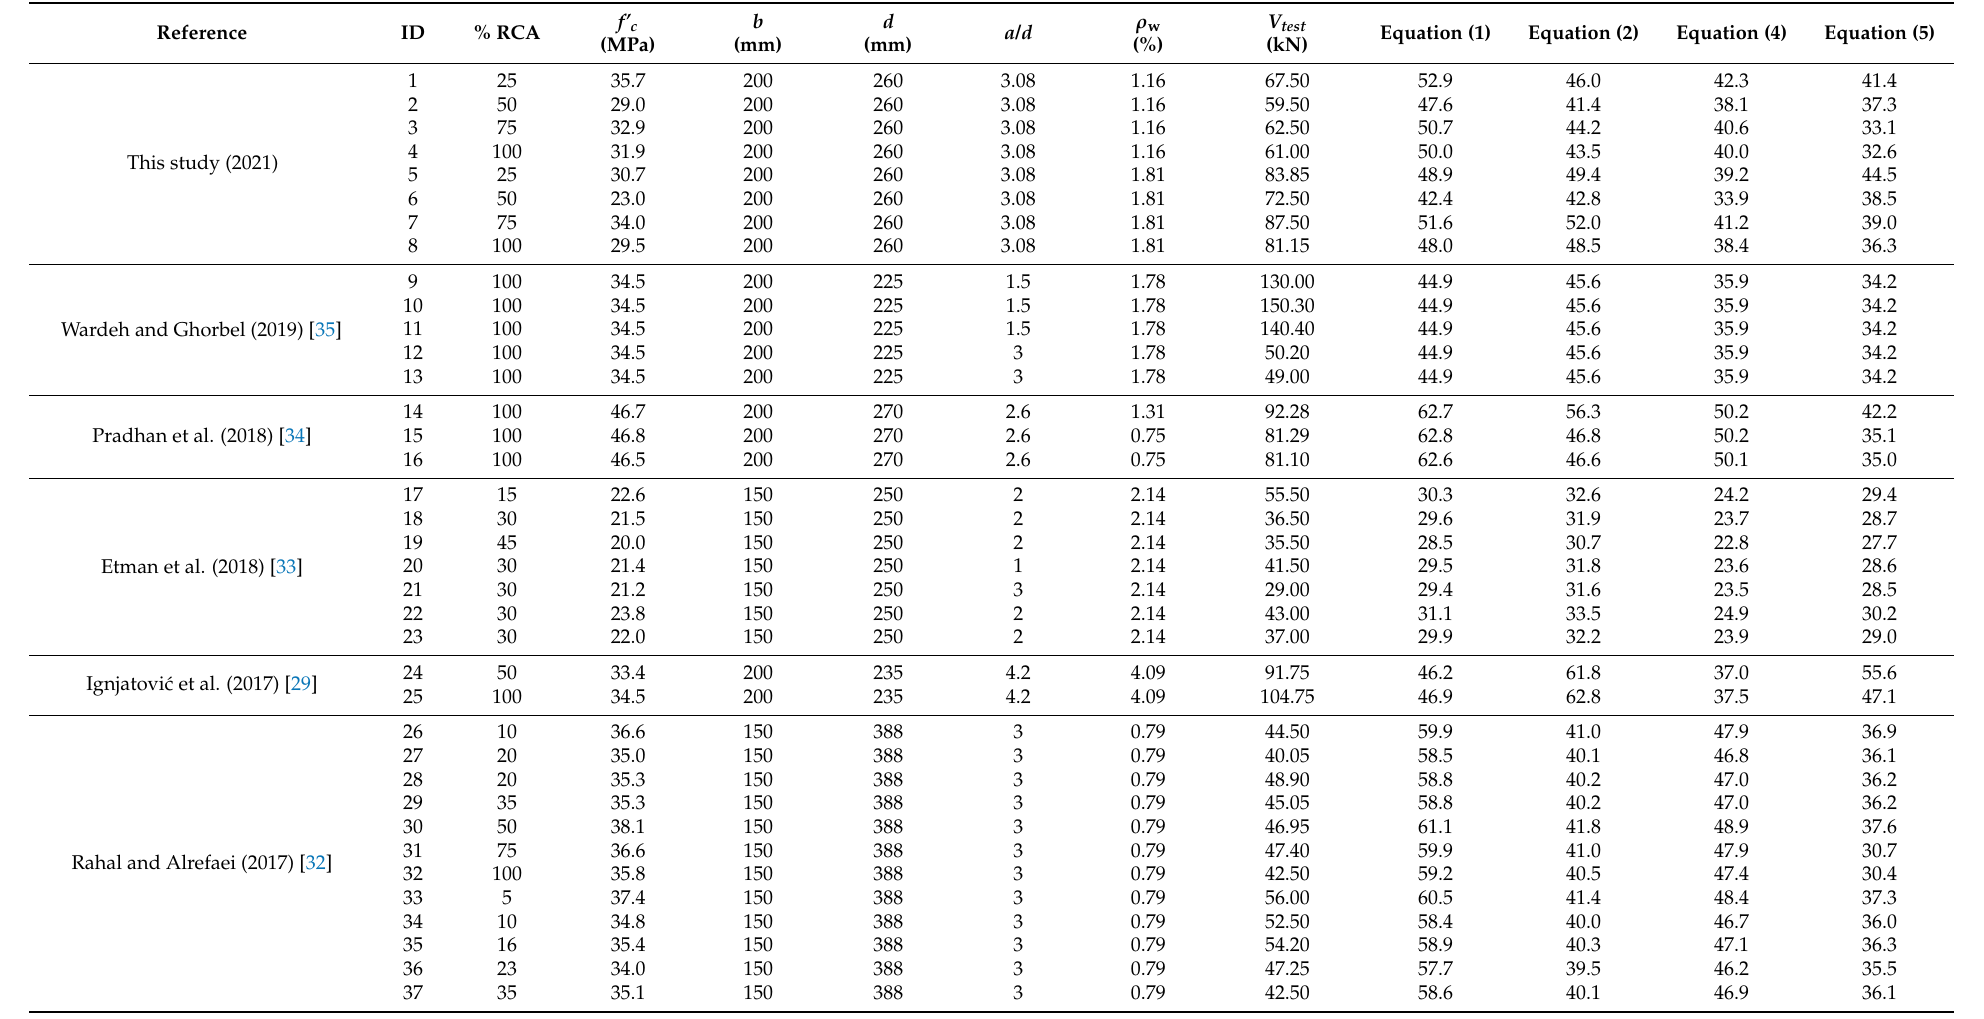
Table A1. Comparison of concrete shear strength of RCA in concrete beams without shear reinforcement by current ACI codes and modified